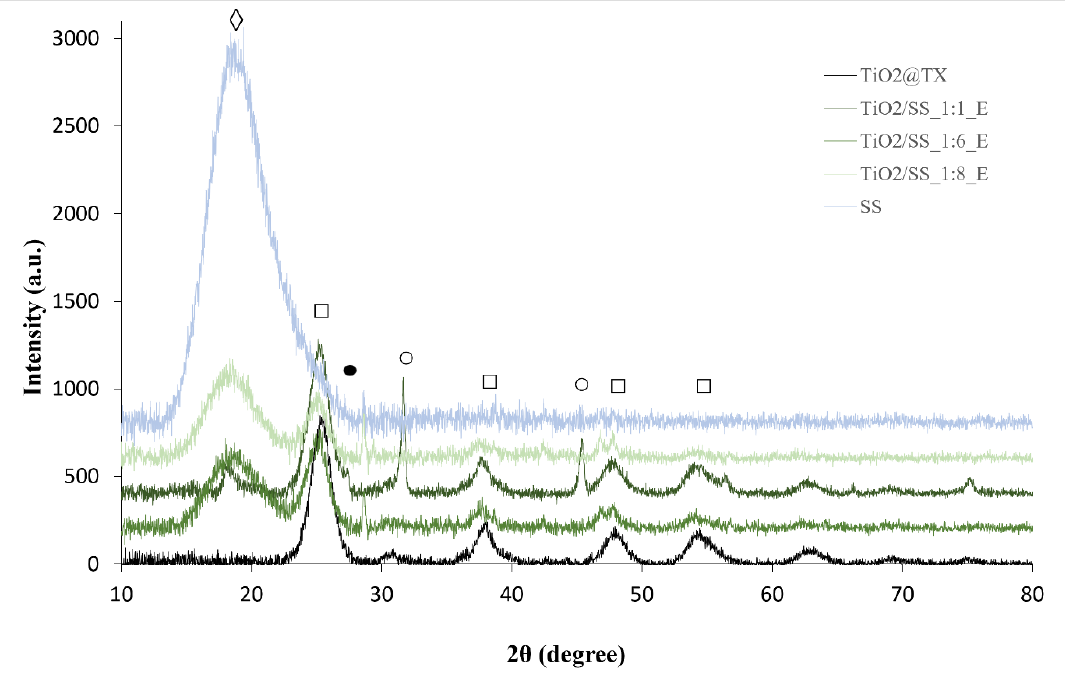
Figure 4. XRD diffractograms of TiO 2 /SS_E_SFD samples (◊ , sodium surfactin; □ , anatase; ● , brook- ite; ○ , sodium chloride).